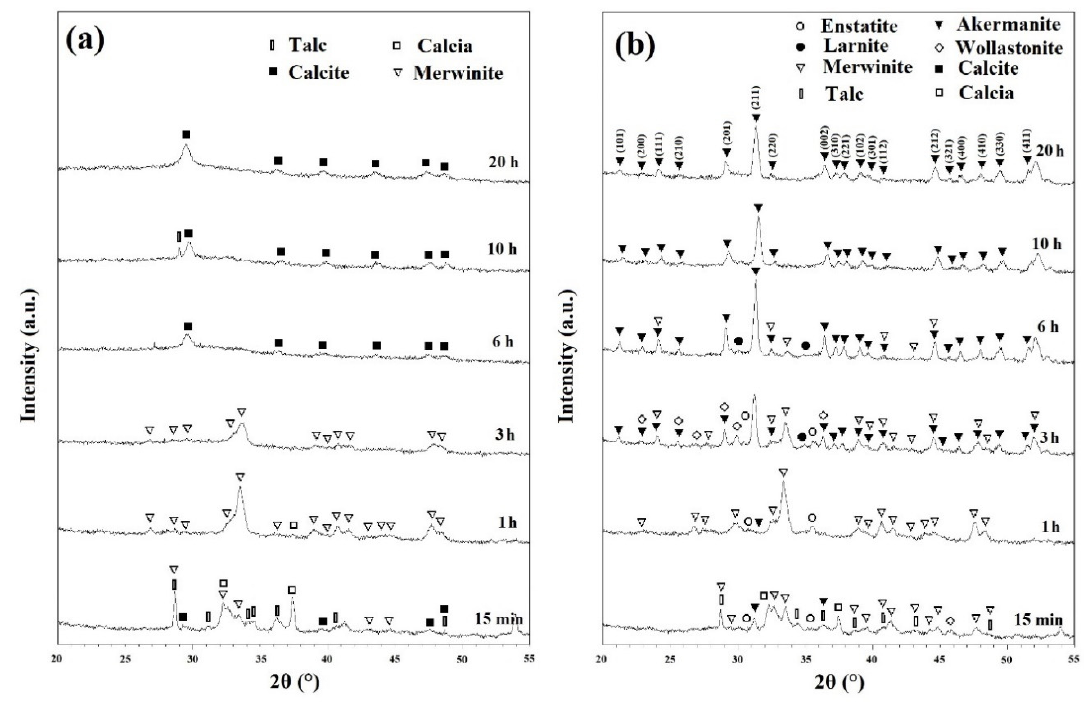
Figure 3. XRD patterns of powders after various ball mill times with subsequent annealing at ( a ) 800 and ( b ) 900 ◦ C for 1 °C and ( b ) 900 °C for 1 h.